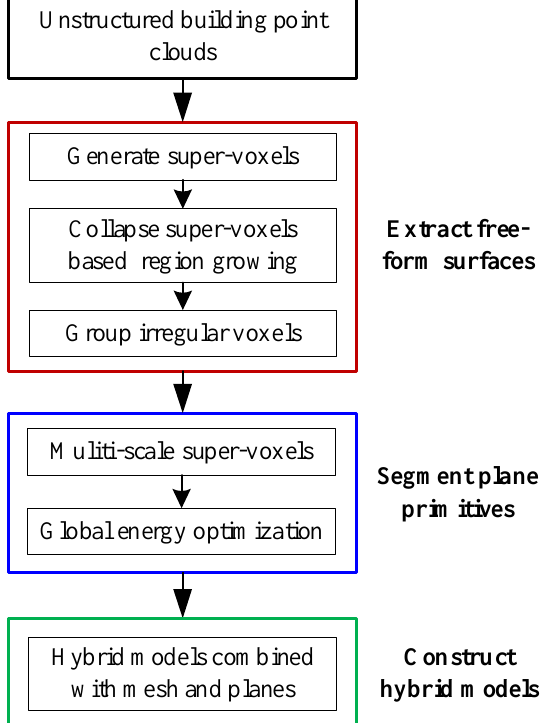
Figure 1. The illustration of the proposed method Taking the individual point cloud as input, an over- segmentation approach is introduced to divide the unorganized point clouds into super-voxels ( Section 3.1.1 ), and a region growing approach based the curvature and normal difference of the adjacent super-voxels is used to collapse similar super- voxels ( Section 3.1.2 ). The nonplanar points belong to the irregular surfaces are extracted by a thickness threshold ( Section 3.1.3 ). Plane primitives are segmented by two